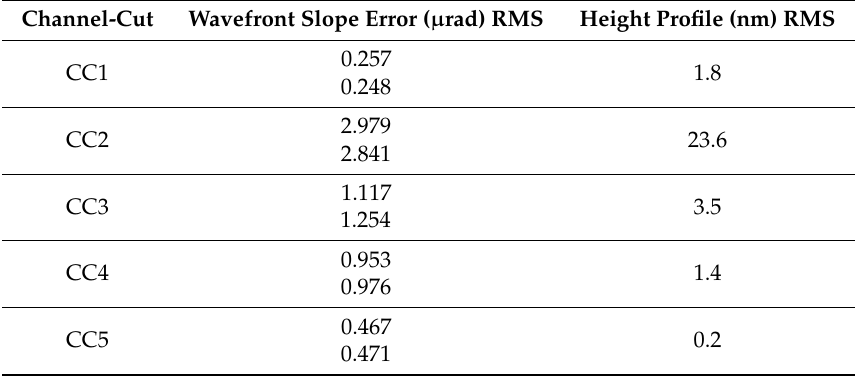
Table 2. Summary of five channel cut crystals’ wavefront measurement results.